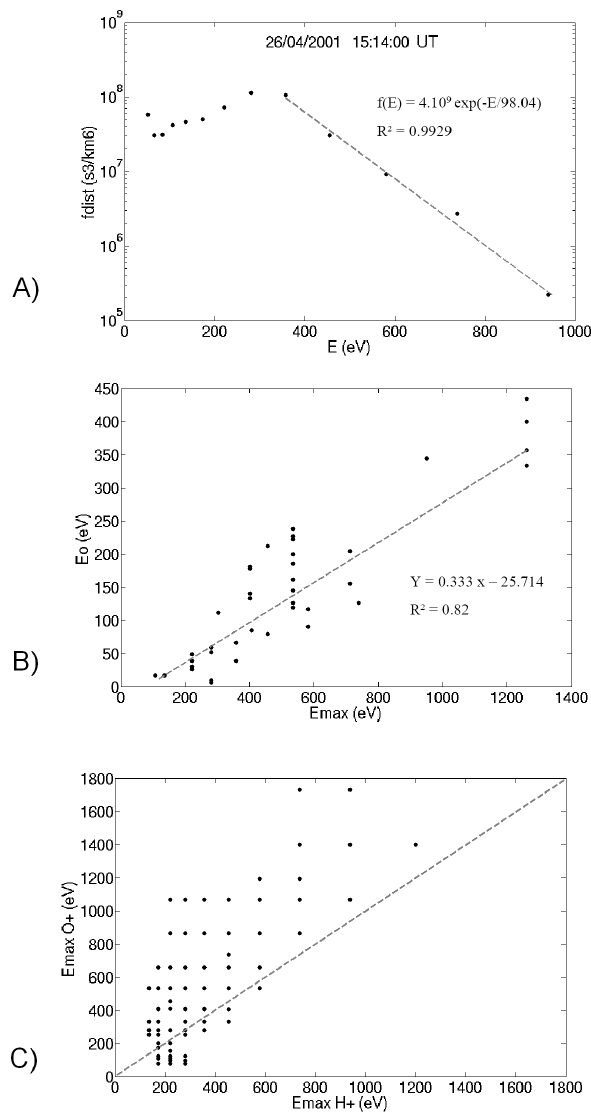
Fig. 14. 26 April 2001. From top to bottom: (A) Ion energetic distribution function at 15:14:00 UT. (B) Thermal energy versus peak energy. (D) O + ions energy versus H + ions